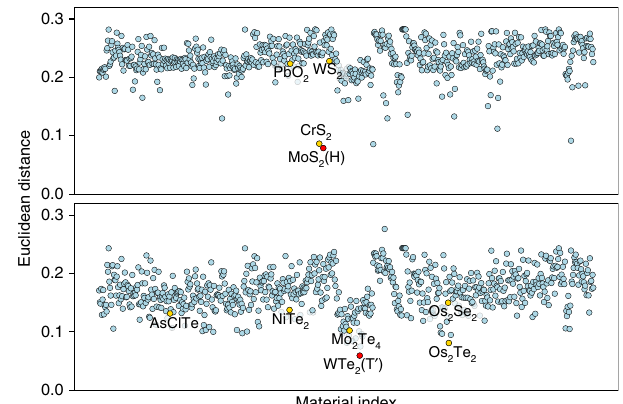
Fig. 6 Calculated Raman moments. Scatter plot of the fi rst Raman moment and normalized standard deviation for 733 calculated spectra at excitation wavelength of 532 nm and xx -polarization setup (circles). For comparison, several independent experimental spectra for monolayer MoS 2 (in H- phase) and WTe 2 (in T 0 -phase) are also shown (stars). We highlight the points corresponding to MoS 2 and WTe 2 in red (H-phase, T 0 -phase, and experiments). The insets are zooms of the vicinity of the experimental data for MoS 2 and WTe 2 . For MoS 2 , 1 – 5 correspond to the experimental spectra obtained from refs. 36,46,79,80 , and 41 , respectively, whereas 1 – 3 for WTe 2 are adopted from refs. 47,81 , and 75 , respectively.